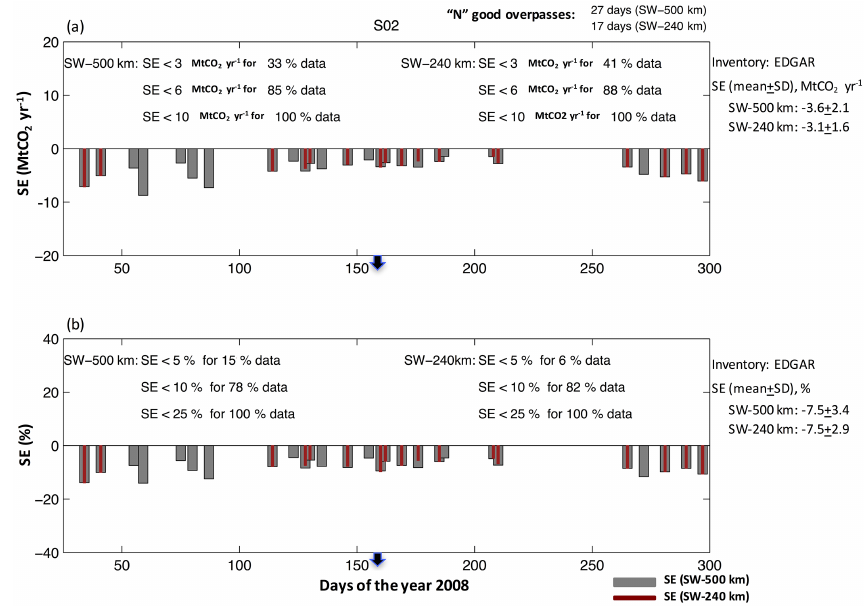
Figure 10. Same as Fig. 9, but for S02, quantifying the impact of the worst-case assumption used for aerosol-related